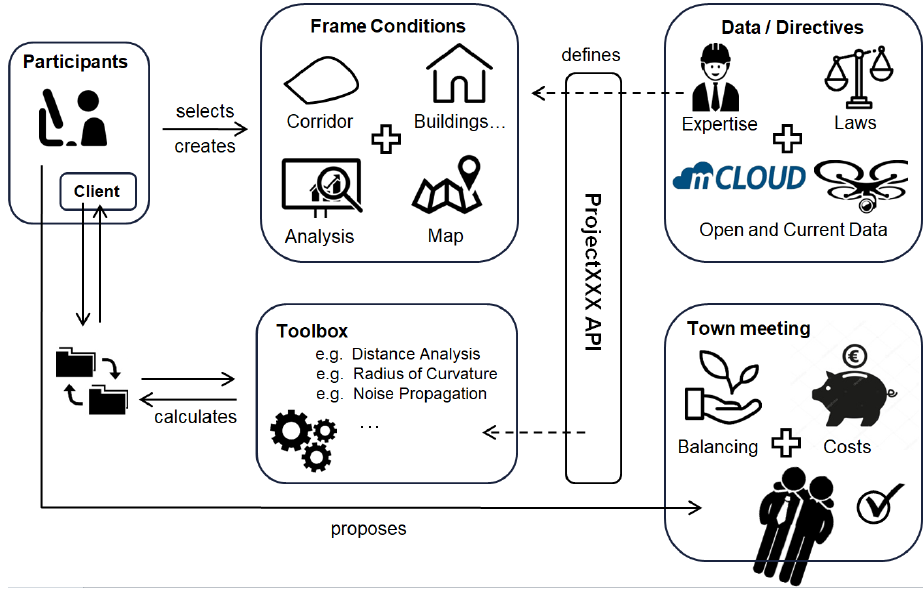
Figure 1: Architecture of the platform InnoPart for web-based citizen participation. Generic planning and formalization tools (InnoPartApi) can be used to set up a server-side planning support system that is accessed by a thin